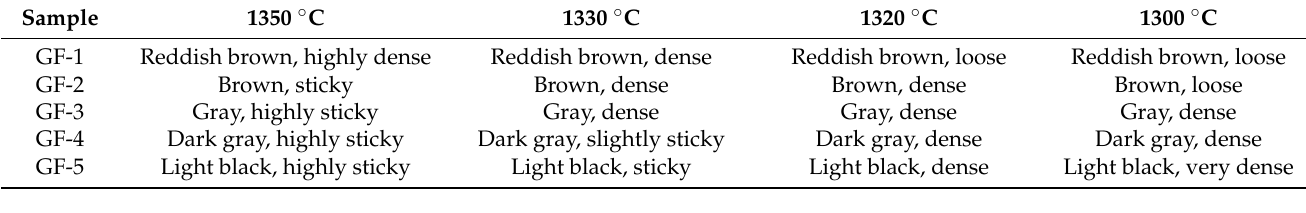
Table 7. Physical appearance observations of HBSC clinker.